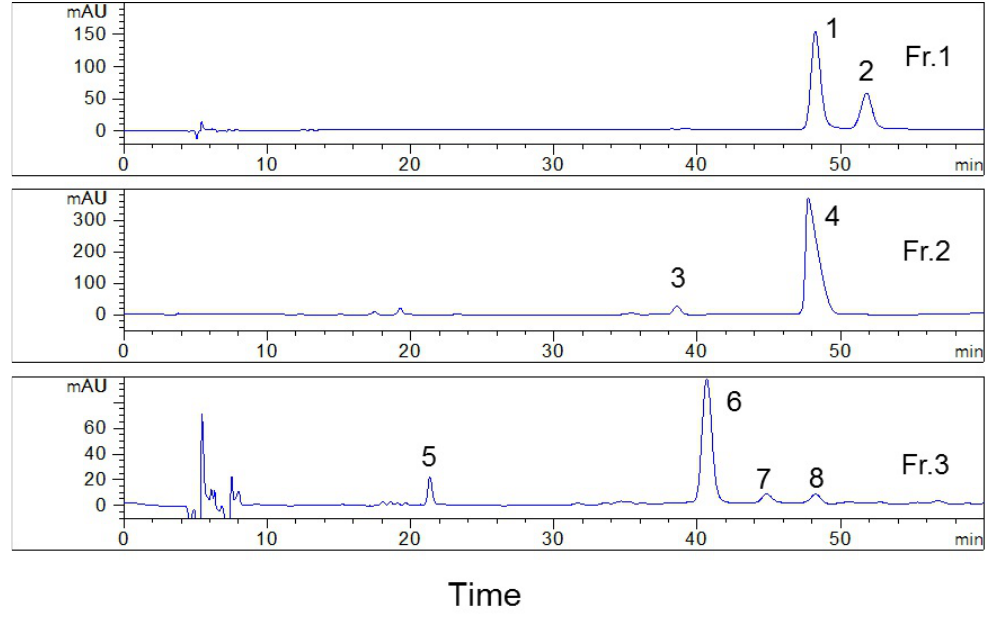
Figure 2. Analytical HPLC chromatograms of fractions collected during the first HPLC separation on the YMC-Pack ODS-AQ column (250 × 4.6 mm). Conditions: mobile phase: water–acetonitrile (82:18, v/v ); flow rate: 0.42 mL/min; column temperature: 25 °C; monitoring wavelength: 269 nm.